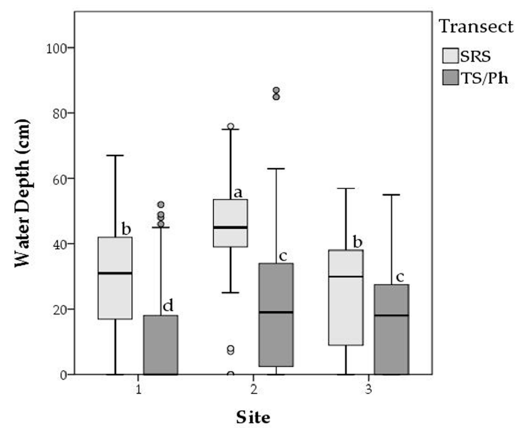
Figure A1. Water depth (cm) along SRS and TS/Ph measured when collecting samples. Significant differences (Games-Howell; p < 0.05) are indicated by different